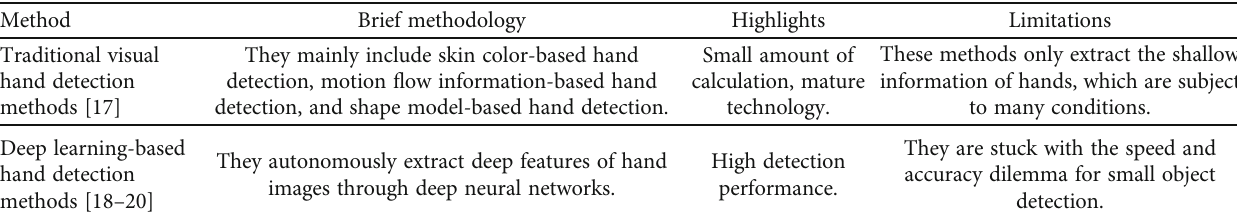
Table 2: Comparison and summary of the hand detection